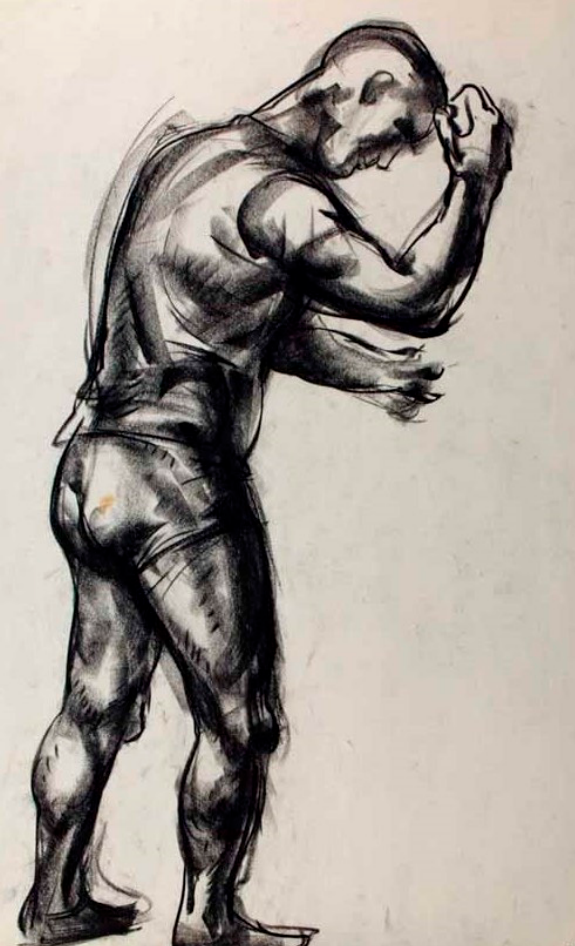
Figure 7. Howard Cook, Figure Study for War Painting , ca. 1943–1945, charcoal on paper. Permanent Collection of the Roswell Museum and Art Center, Gift of the Artist, 1973.025.0076. Used